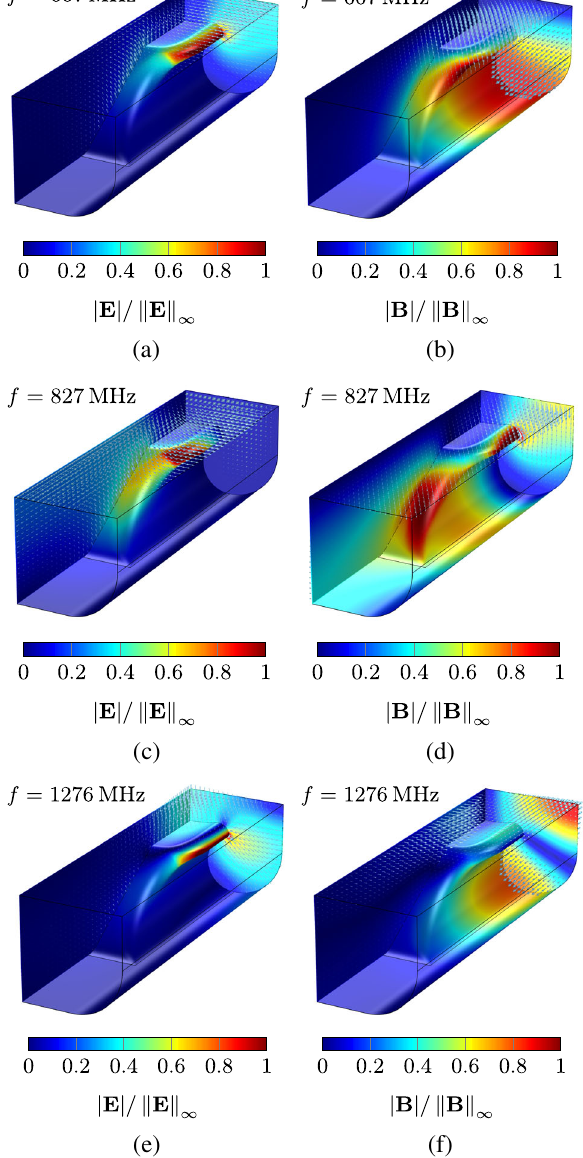
FIG. 7. Normalized electric and magnetic field distributions of the trapped HOMs.